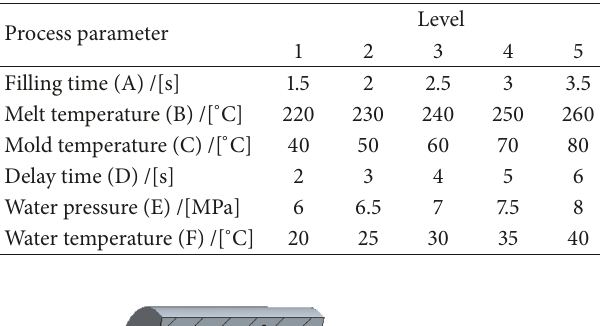
Table 2: Factors and levels of orthogonal experiment design.